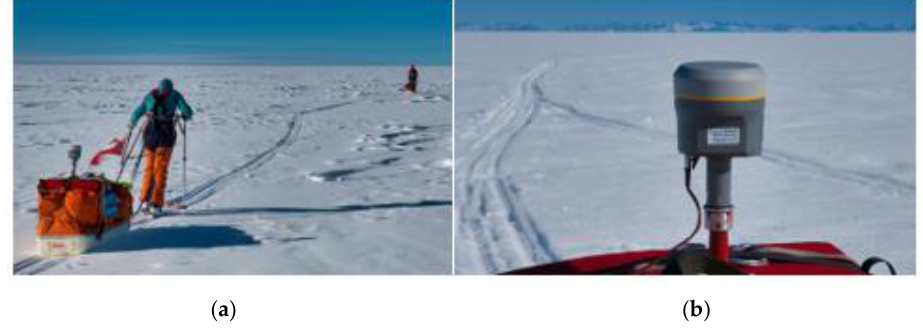
Figure 4. Kinematic GNSS measurement during GKE 2020 ( a ) on the pulka. ( b ) Trimble R12.